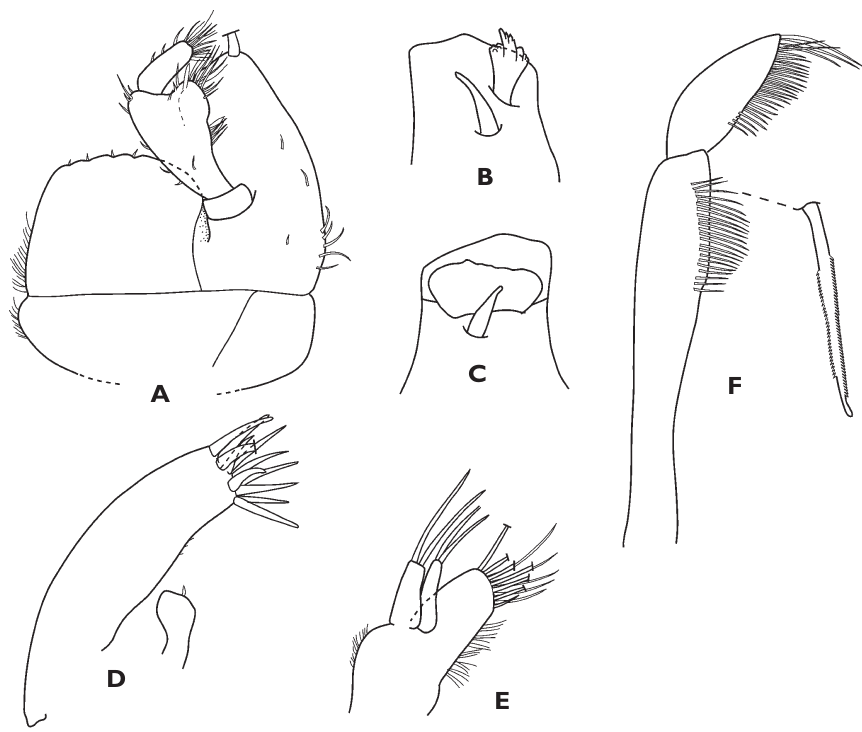
Figure 21. Myopiarolis systir sp. n. Paratype ♂ 11.4 mm, Is.6013. A maxilliped B right mandible, distal margin C left mandible, distal margin D maxillule E maxilla F mandible